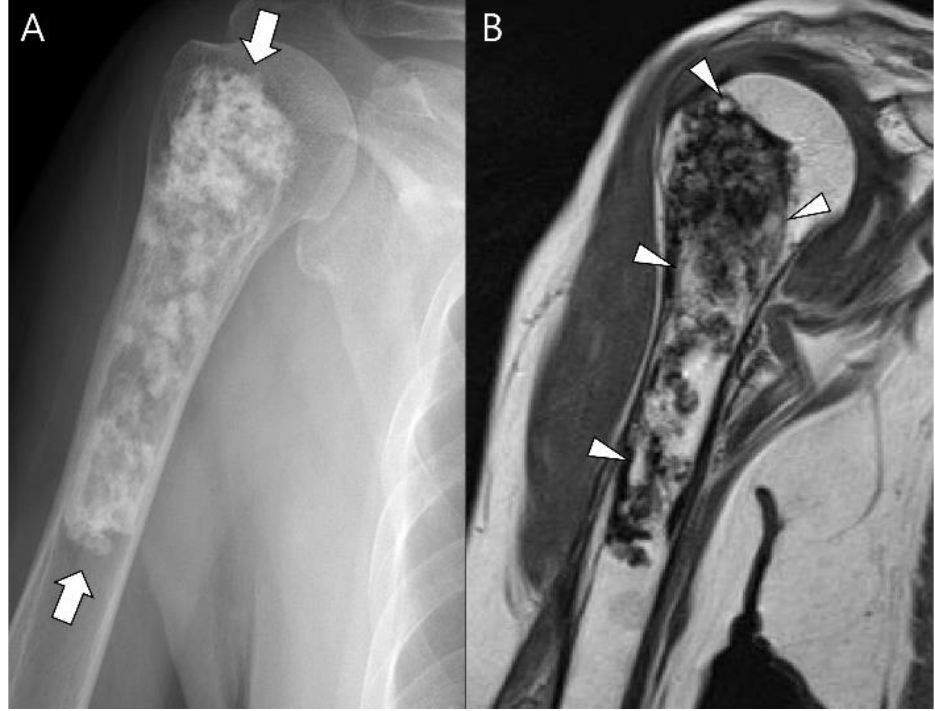
Figure 19. Atypical cartilaginous tumor of the humerus in an 81-year-old woman. ( A ) Plain radiograph demonstrates an intramedullary mass with prominent chondroid matrix mineralization (arrows) in the humerus. ( B ) Coronal T1-weighted image shows a lobulated intramedullary mass with areas of entrapped medullary fat (arrowheads).